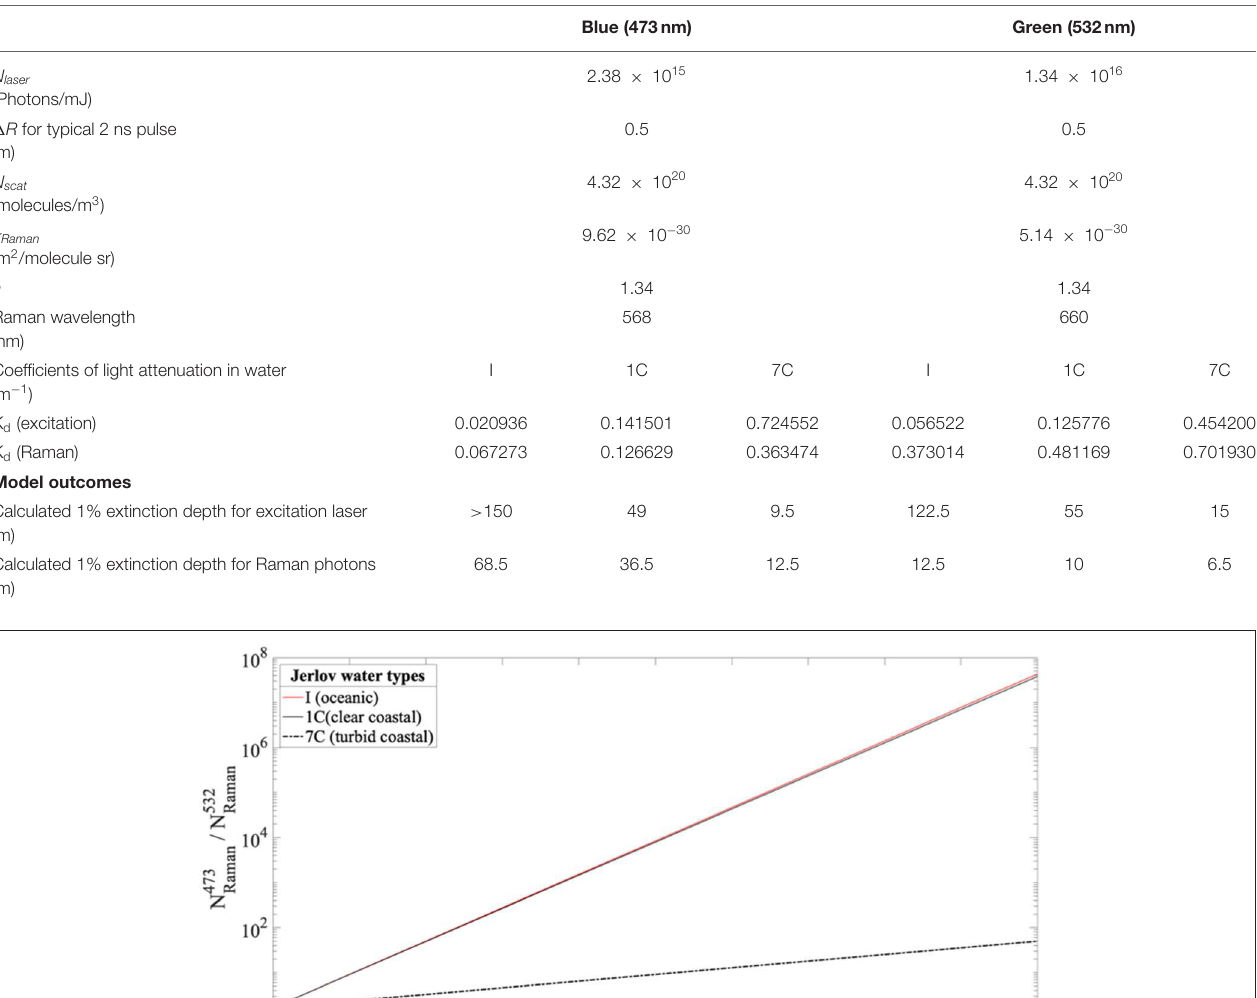
TABLE 5 | Input parameters for LIDAR modeling and outcomes for blue and green excitation lights in Jerlov water types I, 1C and